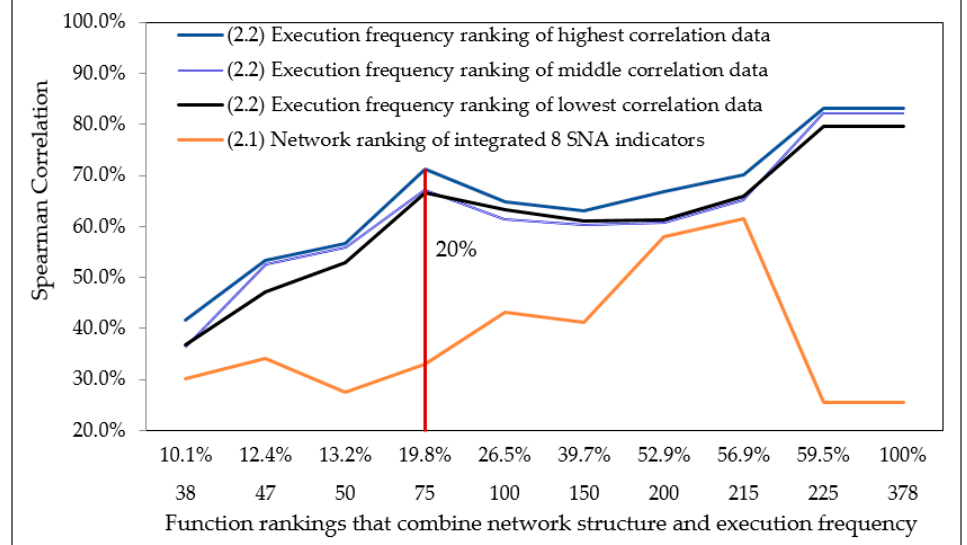
Figure 5. Correlation graph between the function ranking and network and execution frequency.